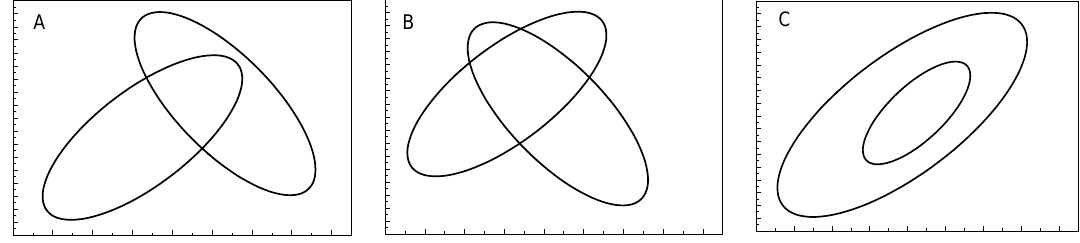
Figure 1. Numbers of intersections of confidence ellipses (crossing numbers, CrN) for various intersection patterns: ( A ) 2; ( B ) 4; ( C ) 4 (postulated).